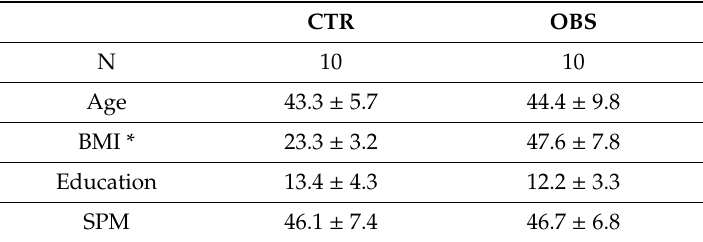
Table 2. Descriptive data of participants’ relevant characteristics. Statistical analyses were performed by unpaired t-test in obese (OBS) vs. control (CTR) group. SPM = Standard Progressive Matrices. (*) for P < 0.05. All data are presented as mean ±